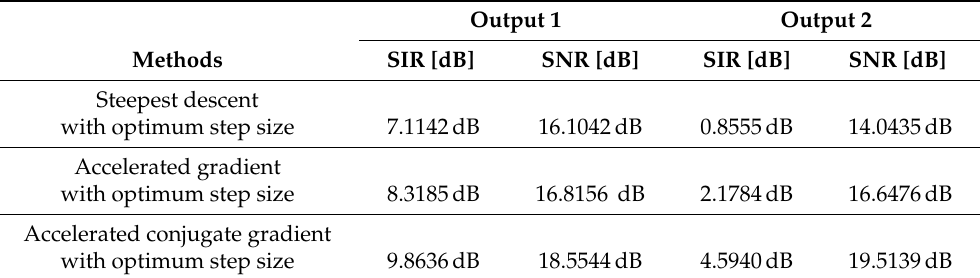
Table 4. Second order BSS in a real car recording environment with two speech sources, noise, and three microphones for the dominant speech output detected by the kurtosis. The SNR is